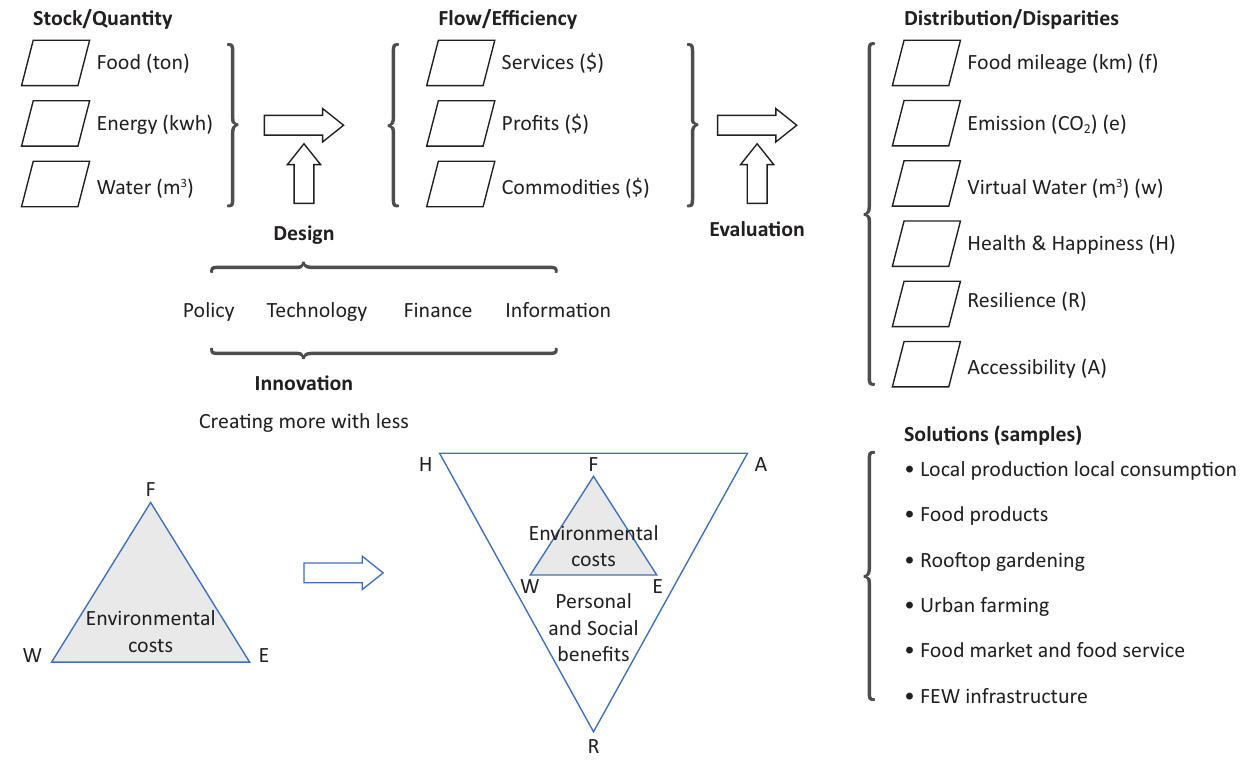
Figure 2. Framework of the moveable nexus. Source: